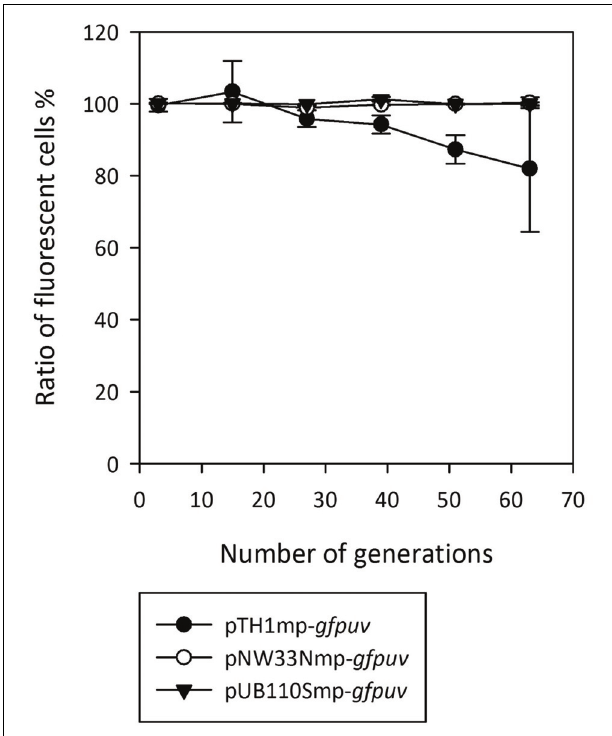
FIGURE 1 | Stability of gfpuv gene expression based on the RC plasmids used in the study. The graph presents the ratio of the fluorescent cells to all the cells analyzed during growth in medium in presence and absence of antibiotics for 60 generations. Means of triplicates with standard deviation are shown.